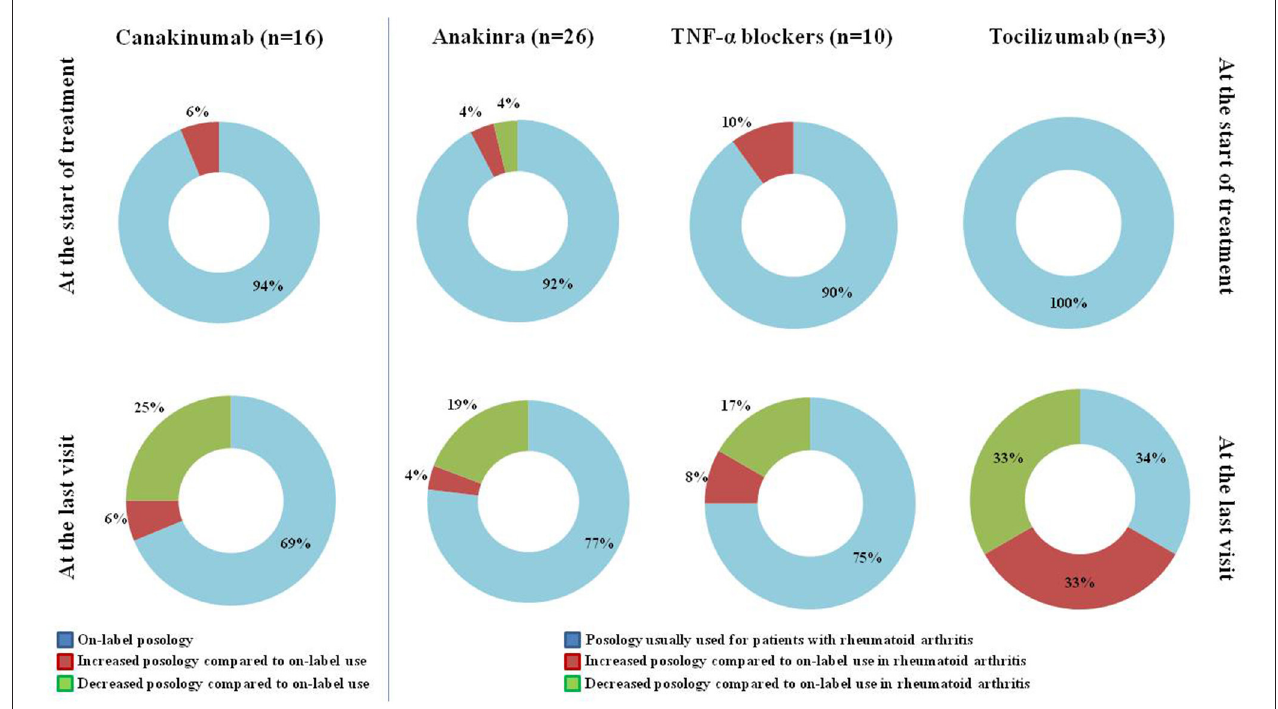
FIGURE 1 | Posology strategies employed at the start of treatment and at the last assessment in the 55 treatment courses considered in the present study. The “ On-label ” posology for canakinumab corresponded to 150 mg/4 weeks (or 2 mg/Kg/4 weeks) to increase to 300 mg/4 weeks (or 4 mg/Kg/4 weeks) in case of unsatisfactory response to the former attempt. The “ Posology usually used for patients with rheumatoid arthritis ” along with the “ on-label use in rheumatoid arthritis ” were meant as 100 mg/day for anakinra, 50 mg/week for etanercept, 40mg every other week for adalimumab, 3 mg/kg every 8 weeks for infliximab, 162 mg/week for tocilizumab. The 4 patients aged < 16 years at the start of anakinra received the posology of 2–4 mg/Kg/day, which is considered “ on-label ” for patients with cryopyrinopathies, and were included in the group “ Posology usually used for patients with rheumatoid arthritis. ” TNF, tumor necrosis factor; n , number of patients (and of treatment courses).